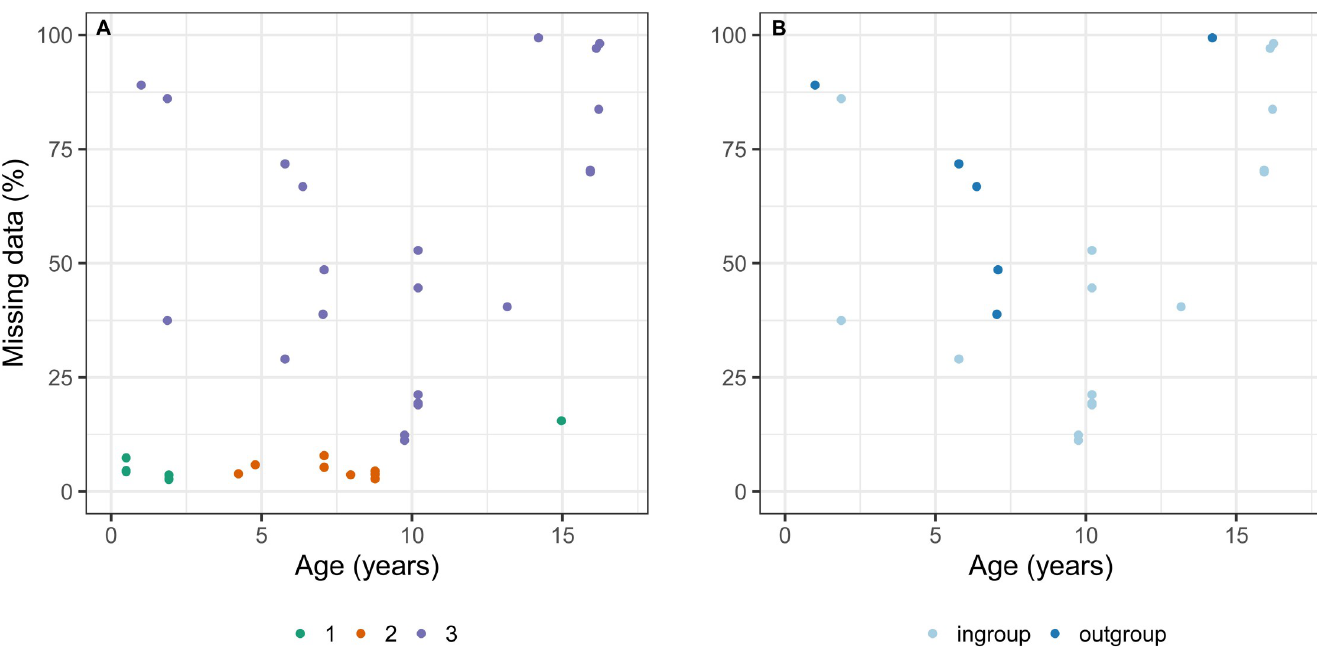
Fig 4. Preservation age of specimens (years) included in the exon captures against (A) missing data (%), and (B) missing data (%) for run 3 sequenced libraries only. Points in (A) are colour-coded by sequencing run, with run 1 indicated in green, run 2 in orange, and run 3 in purple. Points in (B) are coloured by ingroup (light blue) and outgroup (dark blue)